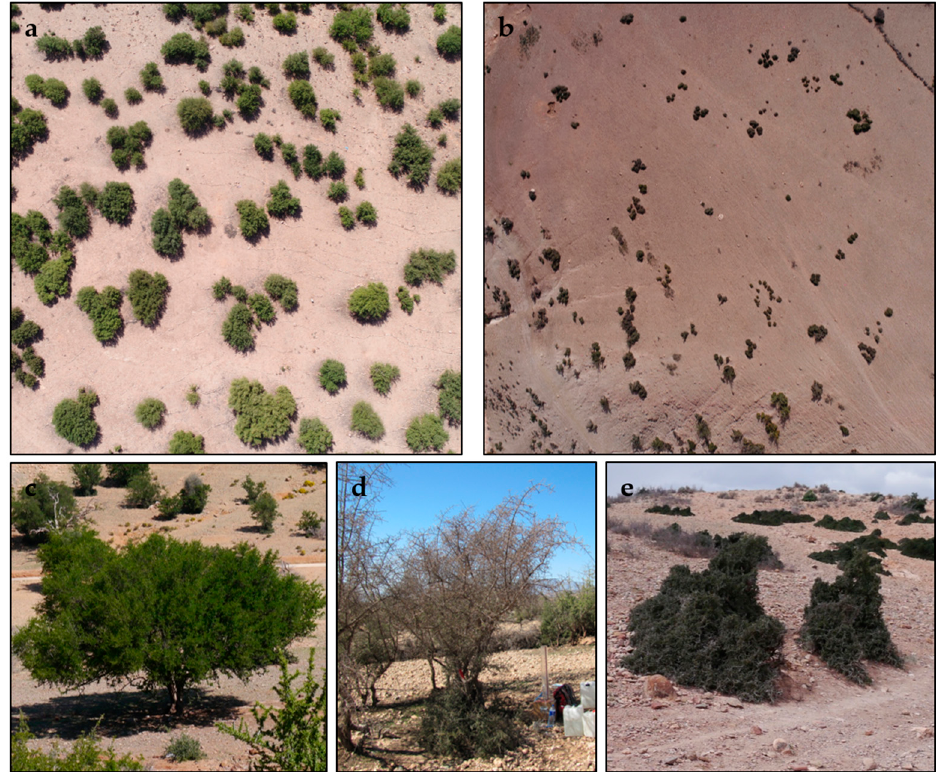
Figure 1. ( a , b ) Varying argan tree densities as seen in vertical aerial photographs (each image in ( a ) and ( b ) shows 1 ha) as well as different growth forms of Argania spinosa : ( c ) round crown; ( d ) umbrella-shaped crown with basal cushion; ( e ) cone-shaped cushion.